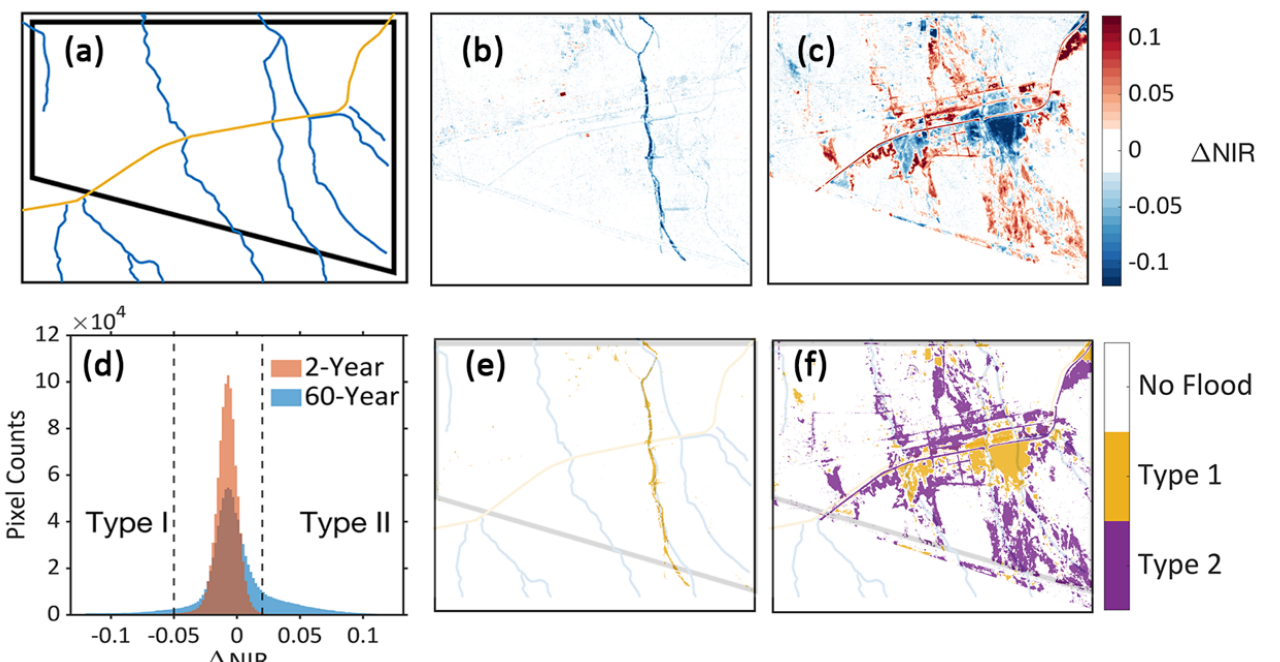
Figure 4. Flood-affected area from CubeSat imagery. ( a ) The boundary of the core area, with blue flowlines and the yellow Gila Bend Canal. ( b ) Δ NIR for the 2018 event (2-year return period). ( c ) Δ NIR for the 2021 storm event (60-year return period). ( d ) Histogram of Δ NIR for two events. ( e ) Flooded area in 2018 event, with ( a ) as reference in background. ( f ) Same as ( e ) but for 2021 event. Type I ponded areas have Δ NIR ≤ − 0.05 whereas Type II flood-impacted areas have Δ NIR ≥ 0.02.